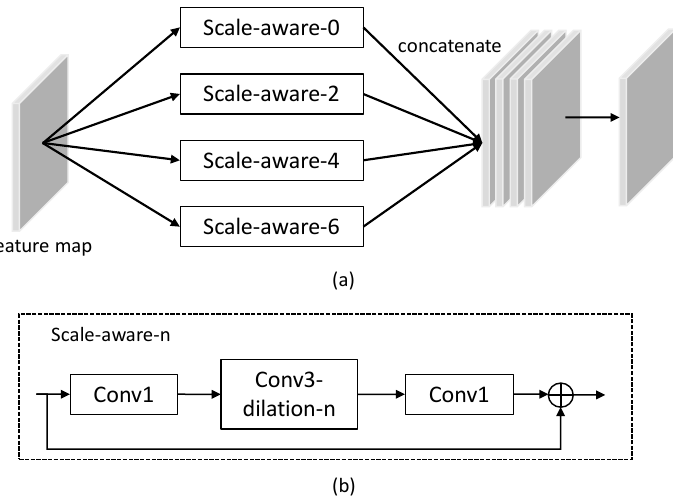
Figure 4. ( a ) shows the architecture of the scale-aware module, and ( b ) shows the dilated convolution module in detail. In ( a ), Scale-aware-n represents a dilated convolution module with expansion rate n . Scale-aware-0 represents a direct connection to transmit the previous layer information more efficiently. In ( b ), Conv1 contains a convolution layer with a kernel size of 1 × 1, a batch normalization layer, and a ReLU layer. Conv3 contains a convolution layer with a kernel size of 3 × 3, a batch normalization layer and a ReLU layer. Conv-dilation-n contains a dilated convolution module with expansion rate n , a batch normalization layer, and a ReLU